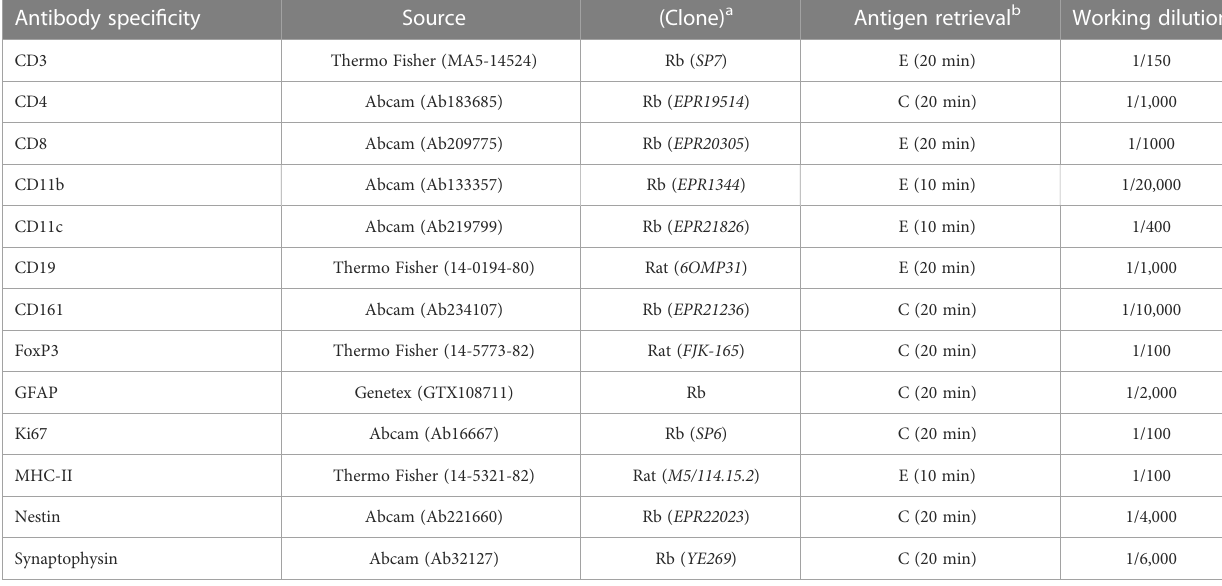
TABLE 1 Antibody reagents used in this